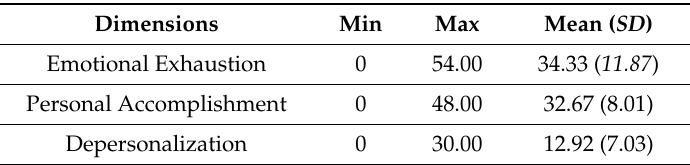
Table 2. Overall mean of burnout dimensions (n = 892).